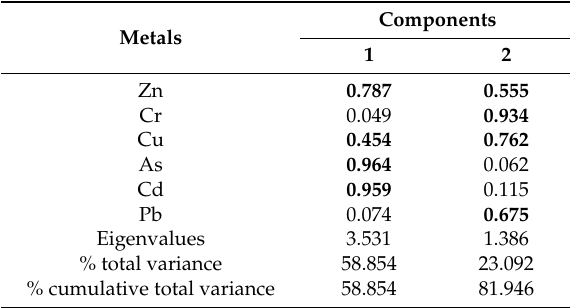
Table 7. Loading corresponding to the first two components for surface sediments of the four rivers.